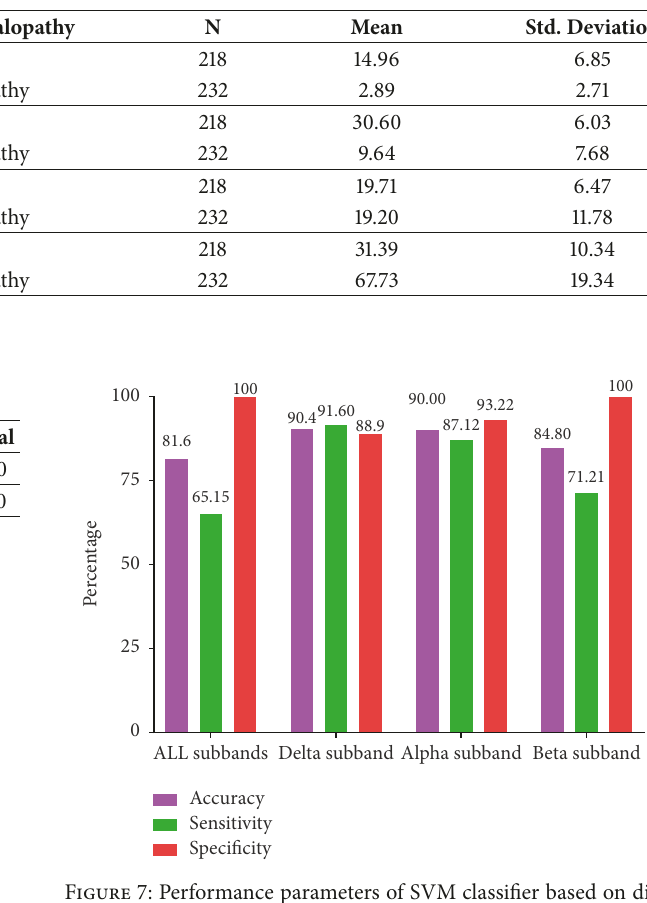
Table 1: Values of mean, standard deviation, and standard error of subbands energies of normal and encephalopathic EEG.